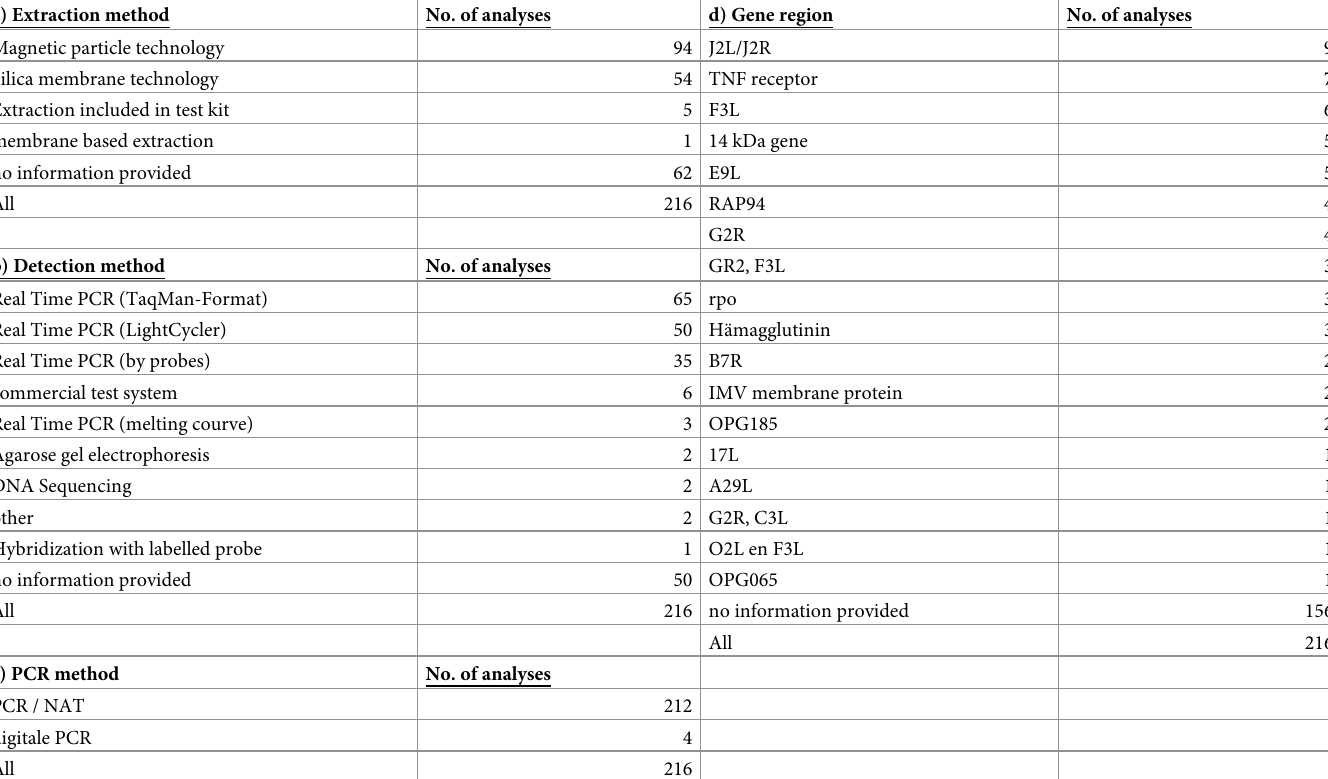
Table 2. Aggregated information provided by the participating laboratories on their methods and target genes used for all analysis combined (qualitative and quan- titative for MPXV and OPXV). a) Extraction